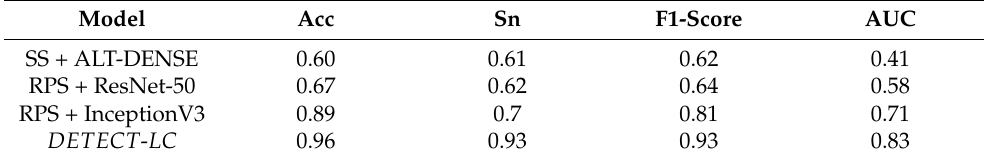
Table 4. Lung Cancer Phenotyping Performance Evaluation on NSCLC Radiomics (Lung 1).